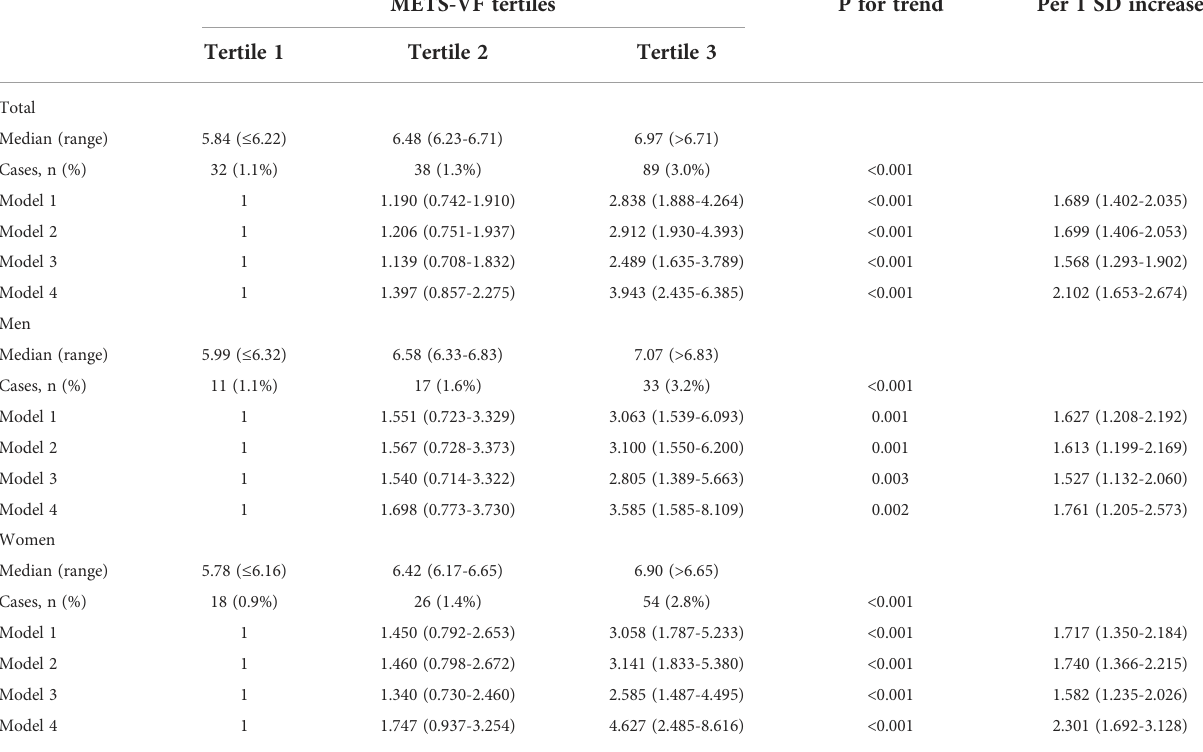
TABLE 2 Associations between METS-VF and